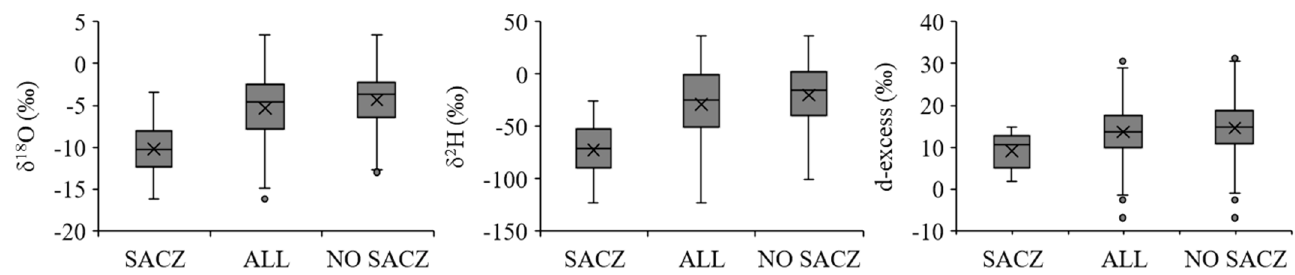
Figure 3. Boxplot of isotopic precipitation composition (δ 18 O, δ 2 H and d-excess) during the occurrence of the South Atlantic Convergence Zone (SACZ) during the entire collection period (ALL), excluding the samples during SACZ performance (NO SACZ). The numerical values of the boxplot are in the Supplementary Material ( Table S2 ).